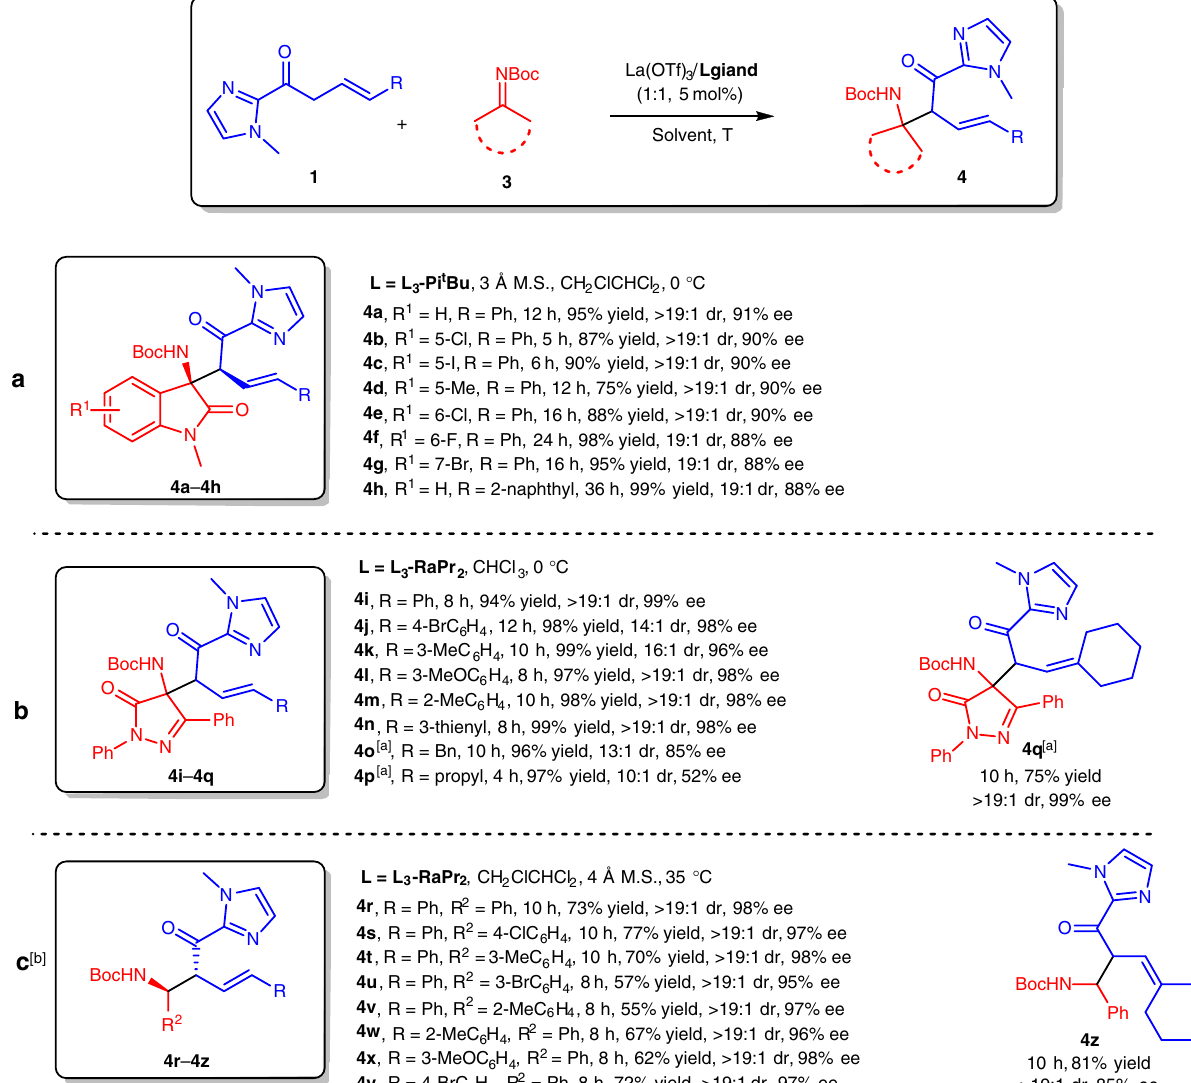
Fig. 4 Substrate scope in α -Mannich reaction of β , γ -unsaturated 2-acyl imidazoles and imines. a Substrate scope with isatin-derived ketimins. b Substrate scope with pyrazolinone-derived ketimins. c Substrate scope with aldimines. Unless otherwise noted, all the reactions were performed with La (OTf) 3 / Ligand (1:1, 5 mol%), 1 (0.10 mmol), 3 (0.10 mmol for 4a – 4q , 0.15 mmol for 4r – 4z ) in the indicated solvent. The dr value was determined by 1 H NMR of crude products. The ee value was determined by HPLC analysis on chiral stationary phases. [a] At 20 °C. [b] With 10 mol% of